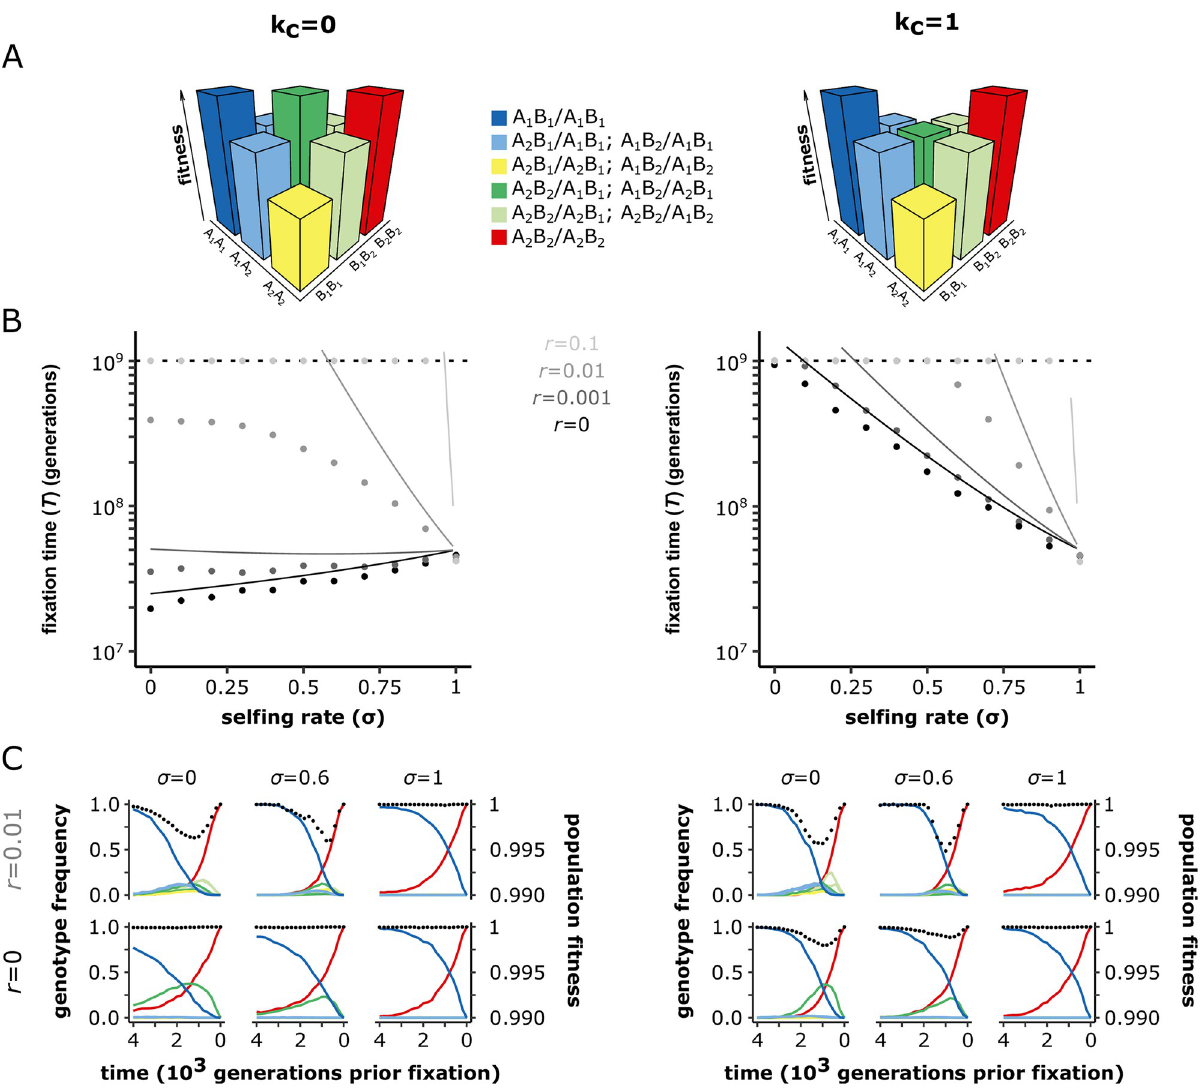
Fig 3. The effect of selfing on the fixation of compensatory mutations depends on the dominance coefficient in the double heterozygote ( k c ), and the recombination rate( r ). (A) Schematic representations of the fitness landscapes for compensatory mutations with k B 1 are the ancestral alleles. A 2 and B 2 are the derived alleles. (B) Time to fixation of a pair compensatory mutations with k c = 0 (left) or k c = 1 (right). The lines correspond to the analytical approximations (Eq 14) for r = 0 (black), r = 0.001 (dark grey), r = 0.01 (grey) and r = 0.1 (light grey). Dots show the corrected mean times to fixation of a pair of compensatory mutations from our two-locus simulations. We corrected the raw means because the threshold made our data right censored ( i.e .,missing estimates above 10 9 generations), which we accounted for by first estimating the full distribution by fitting gamma distributions on our simulation outputs using the fitdistriplus R package [55],from which we estimated the corrected mean times to fixation. The dashed horizontal lines indicate the generation threshold after which simulations stop. N = 1, 000, μ = 10 − 5 , h c = 0.5, s c = 0.01. 1, 000 iterations . (C) Population fitness (black dots—right y axis) and the frequencies of the 10 possible genotypes on the two loci fitness landscapes (solid lines—left y axis) over the last 4200 generations preceding the fixation of the pair of compensatory mutations. The line colours match the genotype colours on the fitness off the diagonal path and eliminating the derived alleles ( A the fixation time in highly selfing populations is less influenced by r and k level of homozygosity (i) makes selfing populations not following the diagonal path of the fit- ness landscape, and (ii) makes the double mutated haplotype ( A to the inefficient recombination in selfers [29].